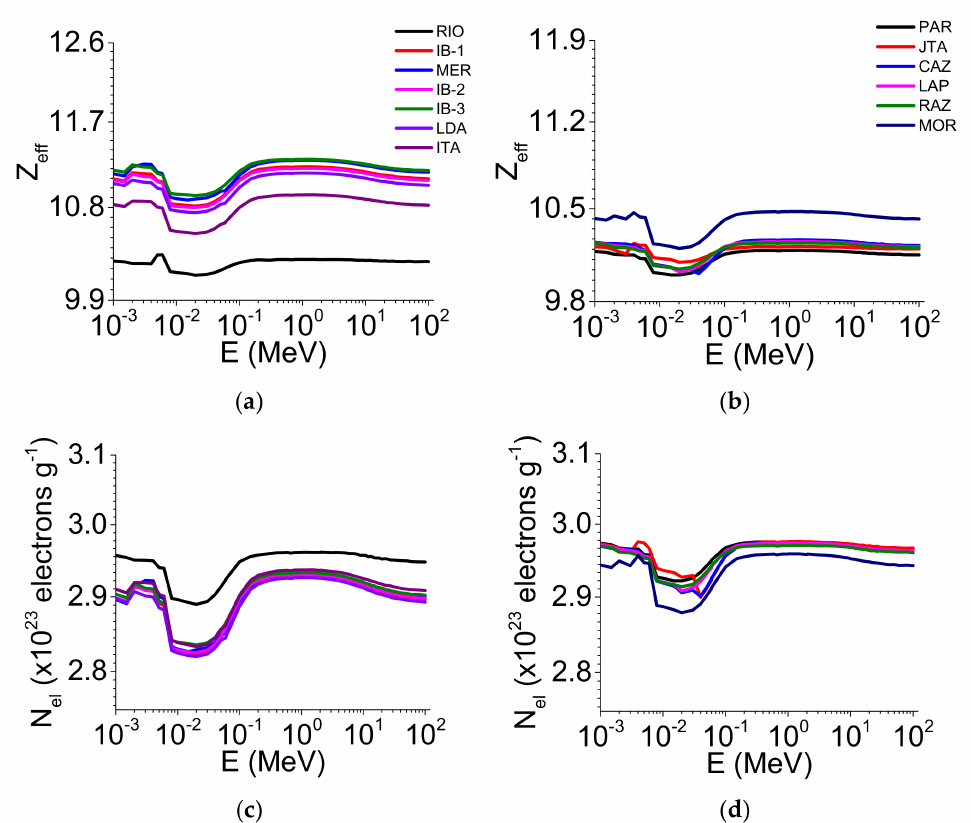
Figure 3. Effective atomic number (Z eff ) and electron density (N el ) variation as a function of the photon energy (E) (1 keV–100 MeV) for the 2–1 mm aggregate sizes in the clayey soils ( a , c ) and the loamy/sandy soils ( b , d